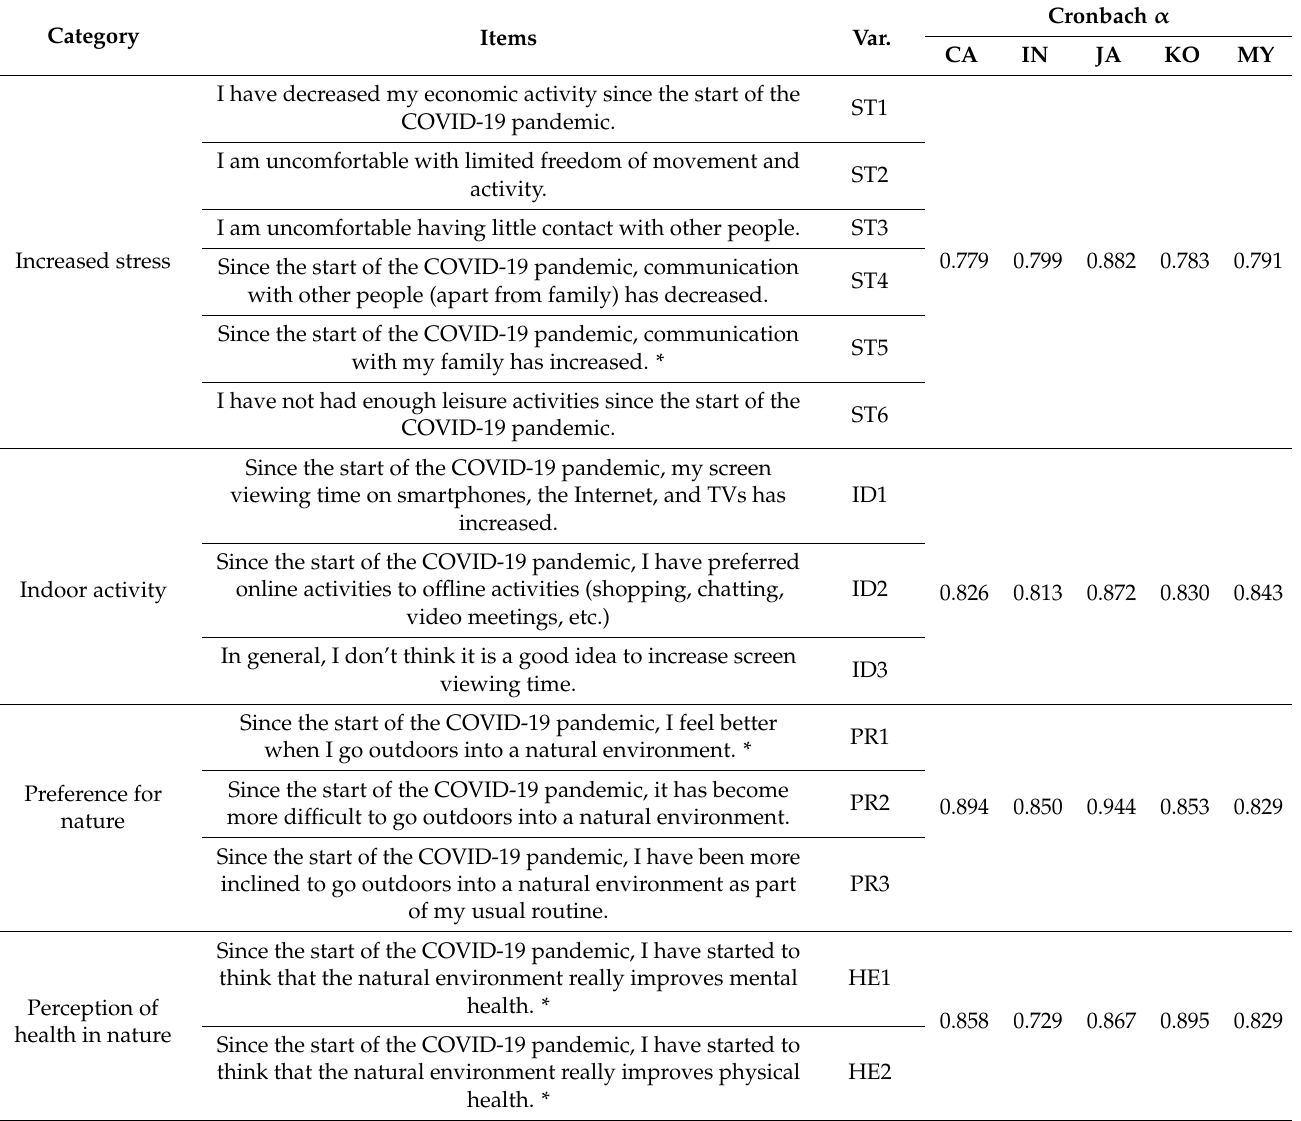
Table 2. Questionnaire reliability by